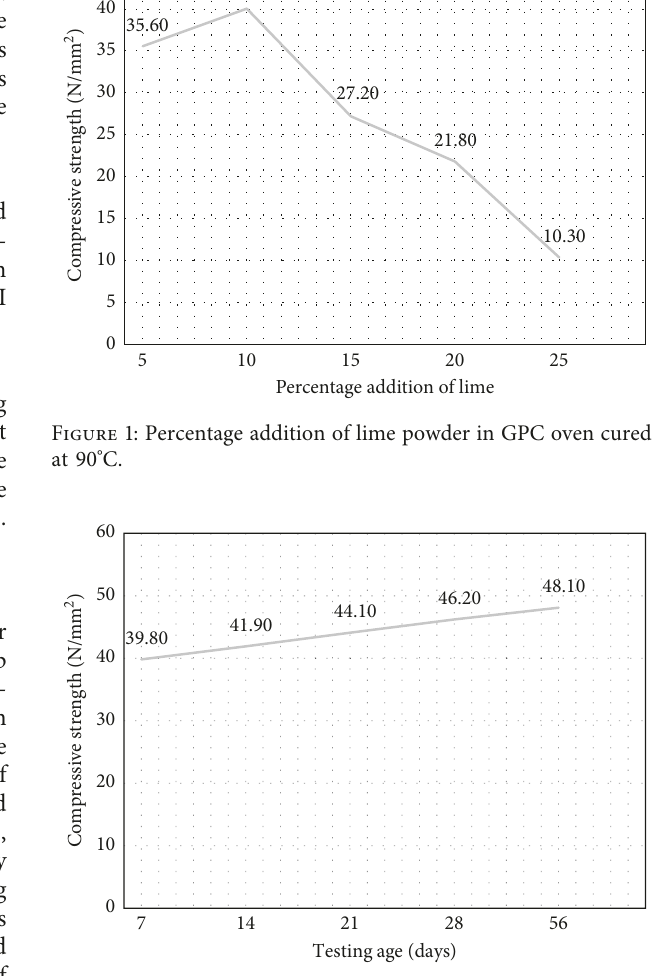
Figure 2: Effect of testing age on geopolymer concrete with oven